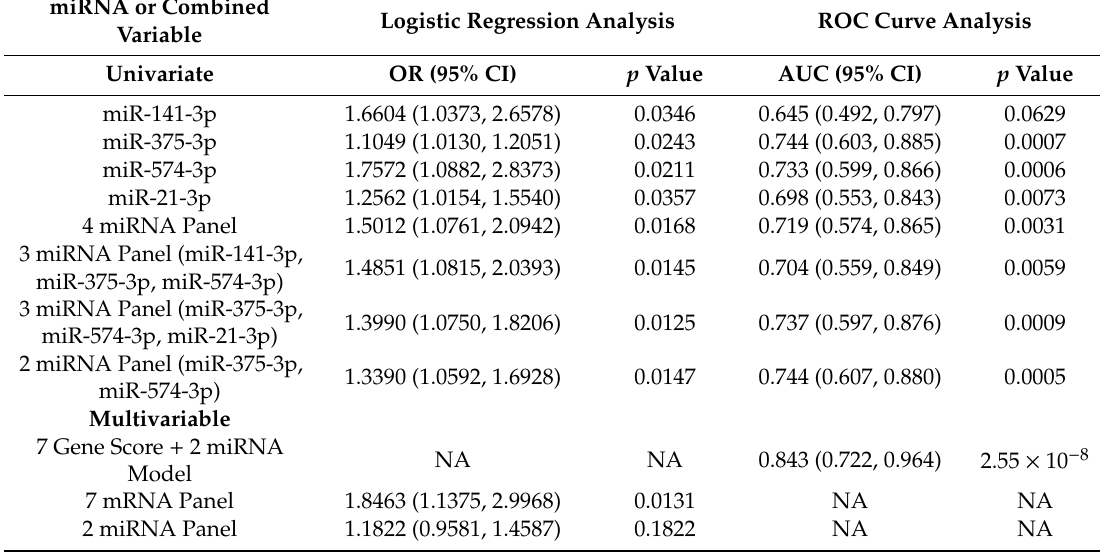
Table 4. Performance of urinary Vn96-isolated EV miRNA biomarkers and combined mRNA + miRNA model for prostate cancer prediction and diagnosis.